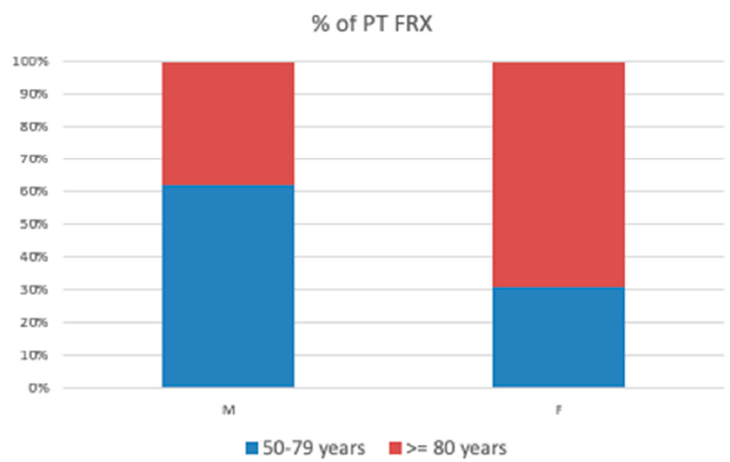
Figure 2. Percentage of the femoral neck (FN) and pertrochanteric (PT) fractures in age groups 50–79 years vs. ≥ 80 years.